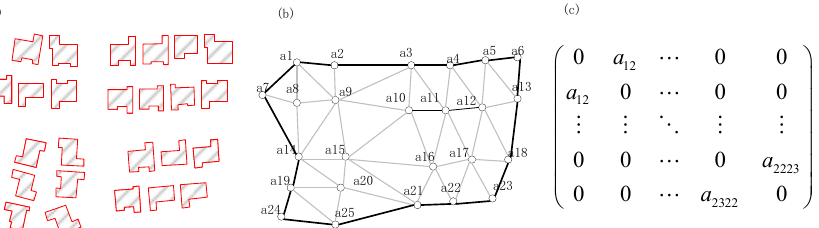
Figure 4. Adjacency relationship graph. ( a ) The polygon; ( b ) the constructed adjacency relationship graph; and ( c ) the corresponding extended adjacency relationship graph model (EAGM).